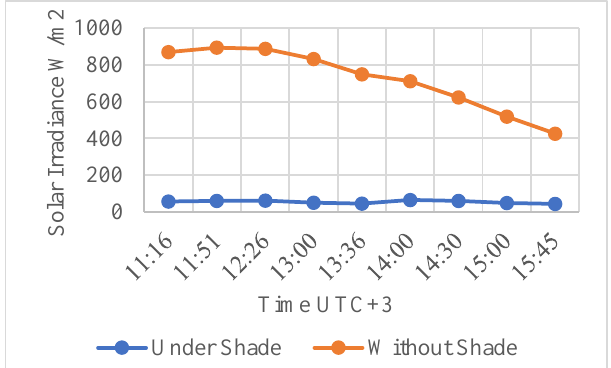
Fig. 14. Solar irradiance under a shade (car parking) and open